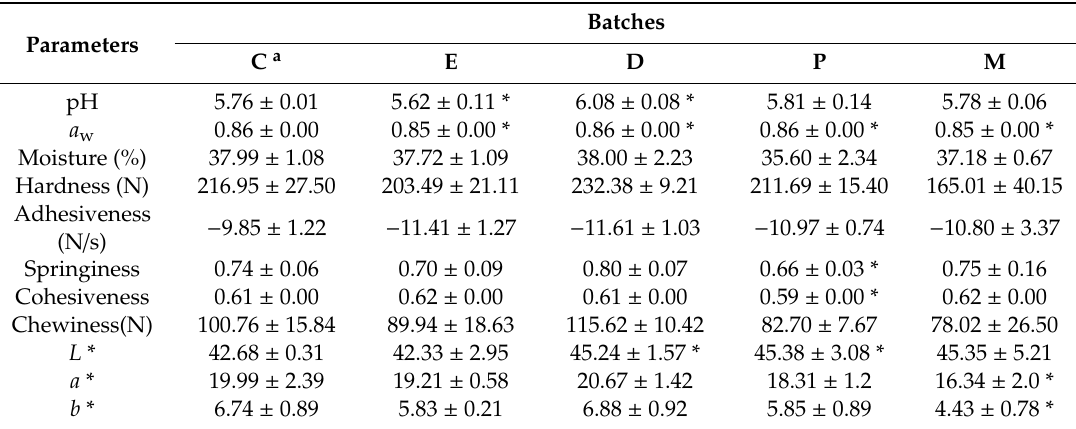
Figure 5. External appearance of dry-cured fermented sausages throughout ripening. ( a ): batch C (without biocontrol agents); ( b ): batch E ( Enterococcus faecium SE920); ( c ): batch D ( Debaryomyces hansenii FHSCC 253H); ( d ): batch P ( Penicillium chrysogenum CECT 20922); ( e ): batch M ( E. faecium SE920 + D. hansenii FHSCC 253H + P. chrysogenum CECT 20922). Table 1. Values of pH, water activity ( a w ), moisture, instrumental texture parameters (hardness, adhesiveness, springiness, cohesiveness, and chewiness), and CIE L * a * b * parameters of dry-cured fermented sausage (salchichón) inoculated with biocontrol agents after 21 days of ripening.